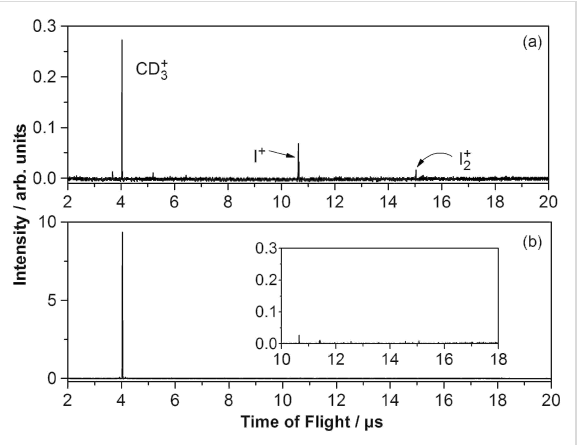
Figure 4: Mass spectra recorded at (a) 150 K and (b) 100 K from the same sample surface as in Figure 3 period C, after 3500 s. The inset presents a zoom-in to the mass spectrum (b). During the recording of the mass spectra, CD 3 I was continuously dosed onto the surface. Pump pulse: 266 nm, 2 mW/cm²; probe pulse: 333 nm, 600 mW/cm²; pump–probe delay time: 130 fs.